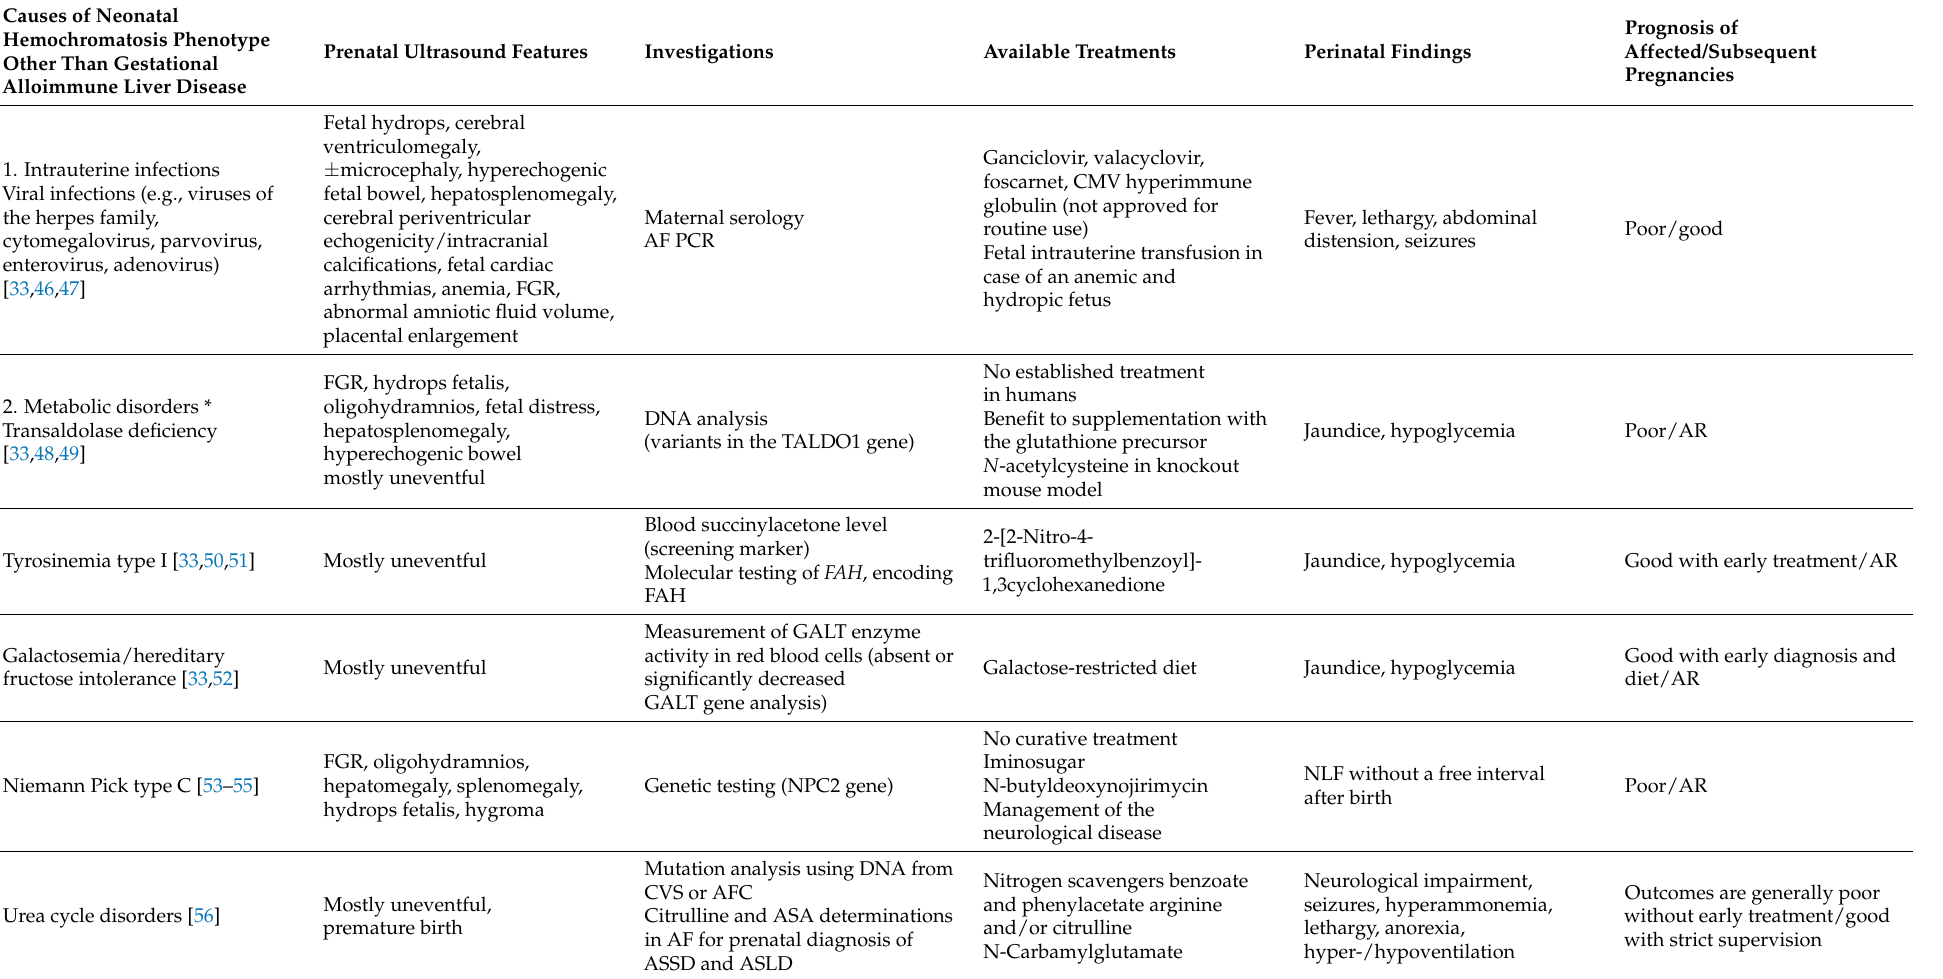
Table 2. Differential diagnosis of neonatal hemochromatosis in neonatal liver